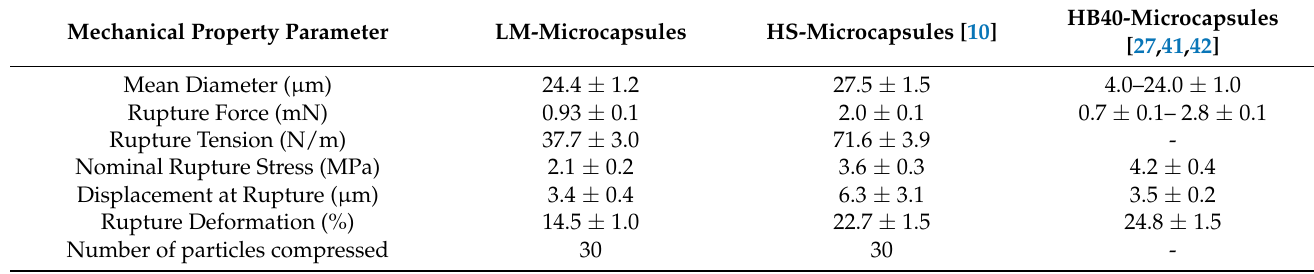
Table 1. Key mechanical property parameters of LM microcapsules in comparison with other microcapsules reported in literature (Mean ± St.